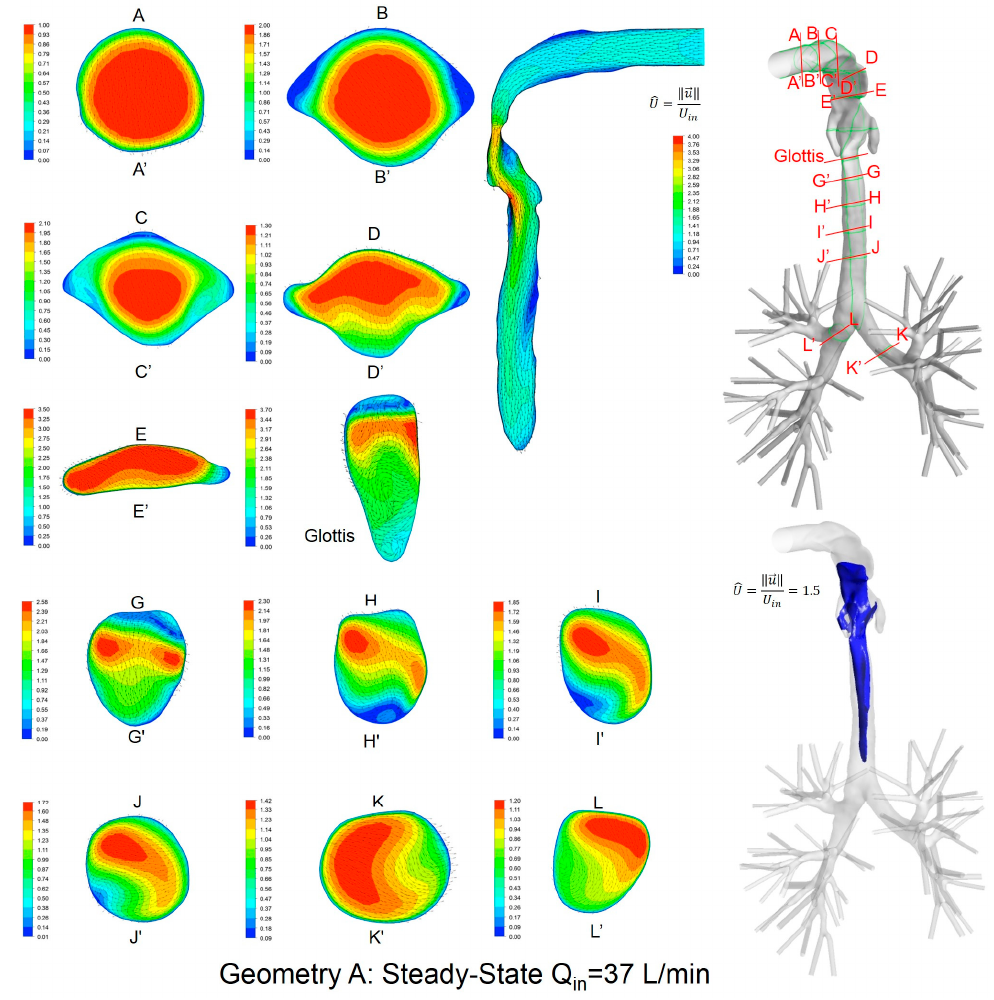
Figure 6. Dimensionless velocity distributions and laryngeal jet core at multiple cross-sections and the sagittal plane of Geometry A under a steady-state inhalation flow rate of Q in = 37 L/min. General flow patterns include: